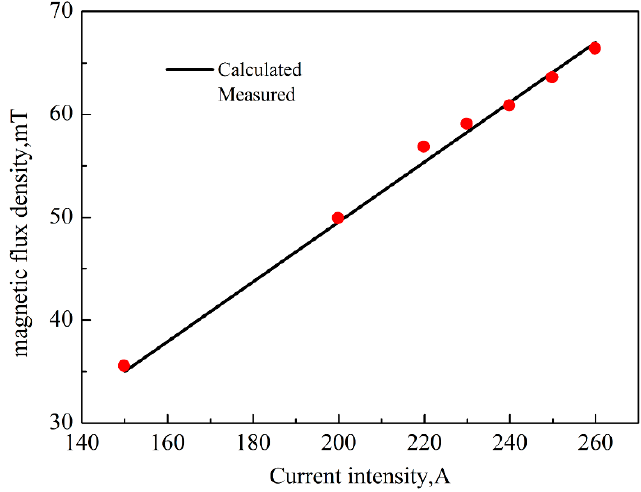
Figure 3. Comparison of the calculated and measured magnetic flux density in M ‐ EMS.